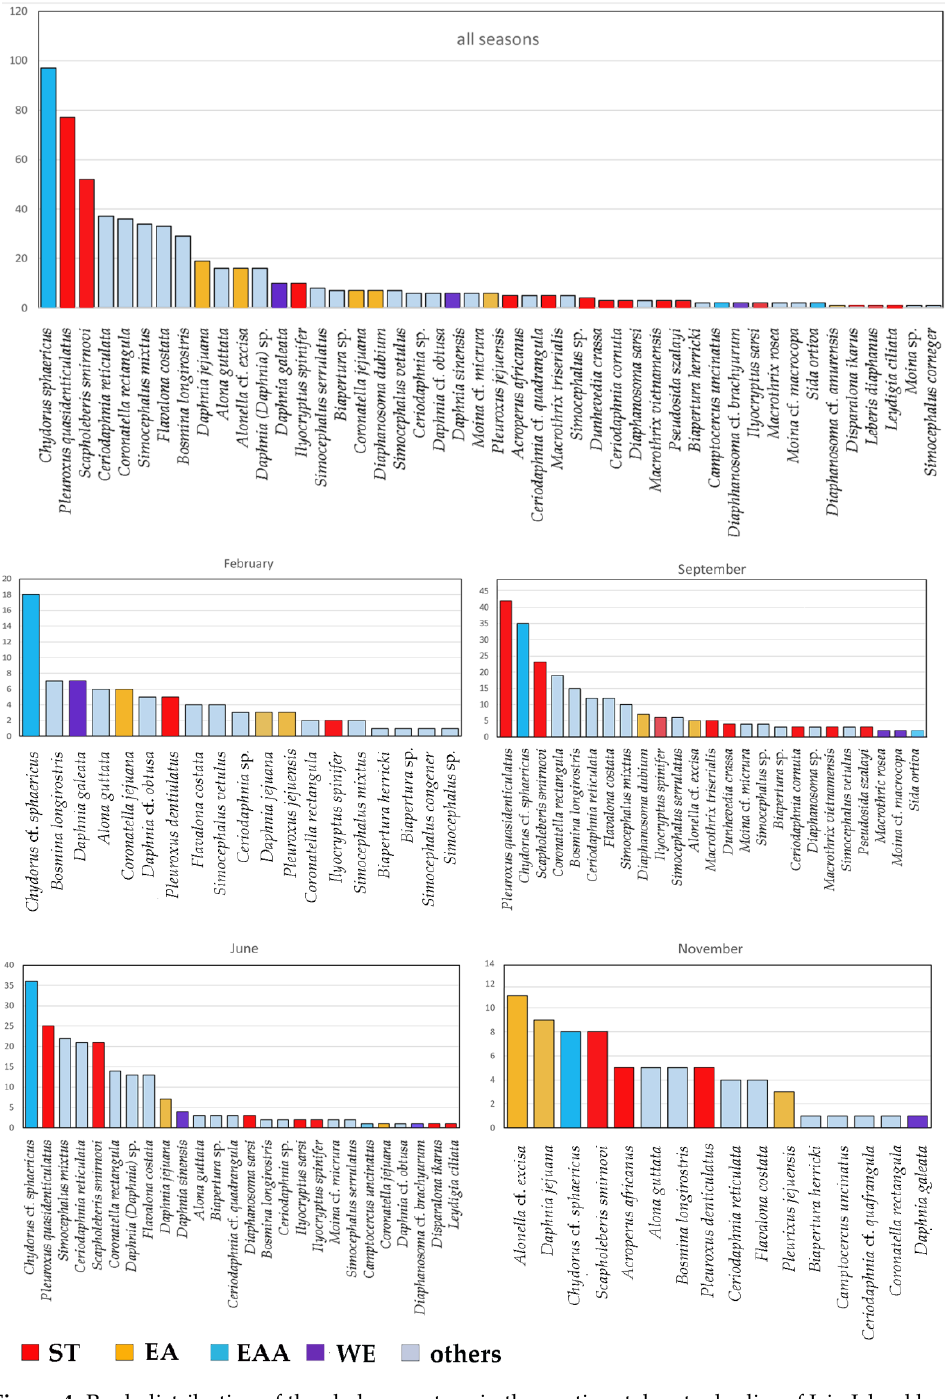
Figure 4. Rank distribution of the cladoceran taxa in the continental water bodies of Jeju Island based on the number of records during all seasons ( top panel) and each season separately ( bottom panels). Colors mean belonging to different faunistic complexes.